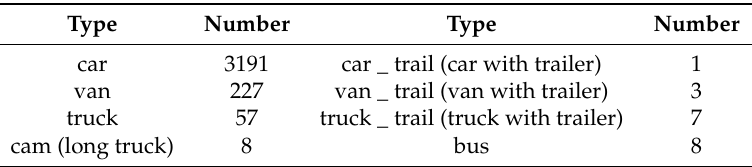
Table 2. Number of each type of